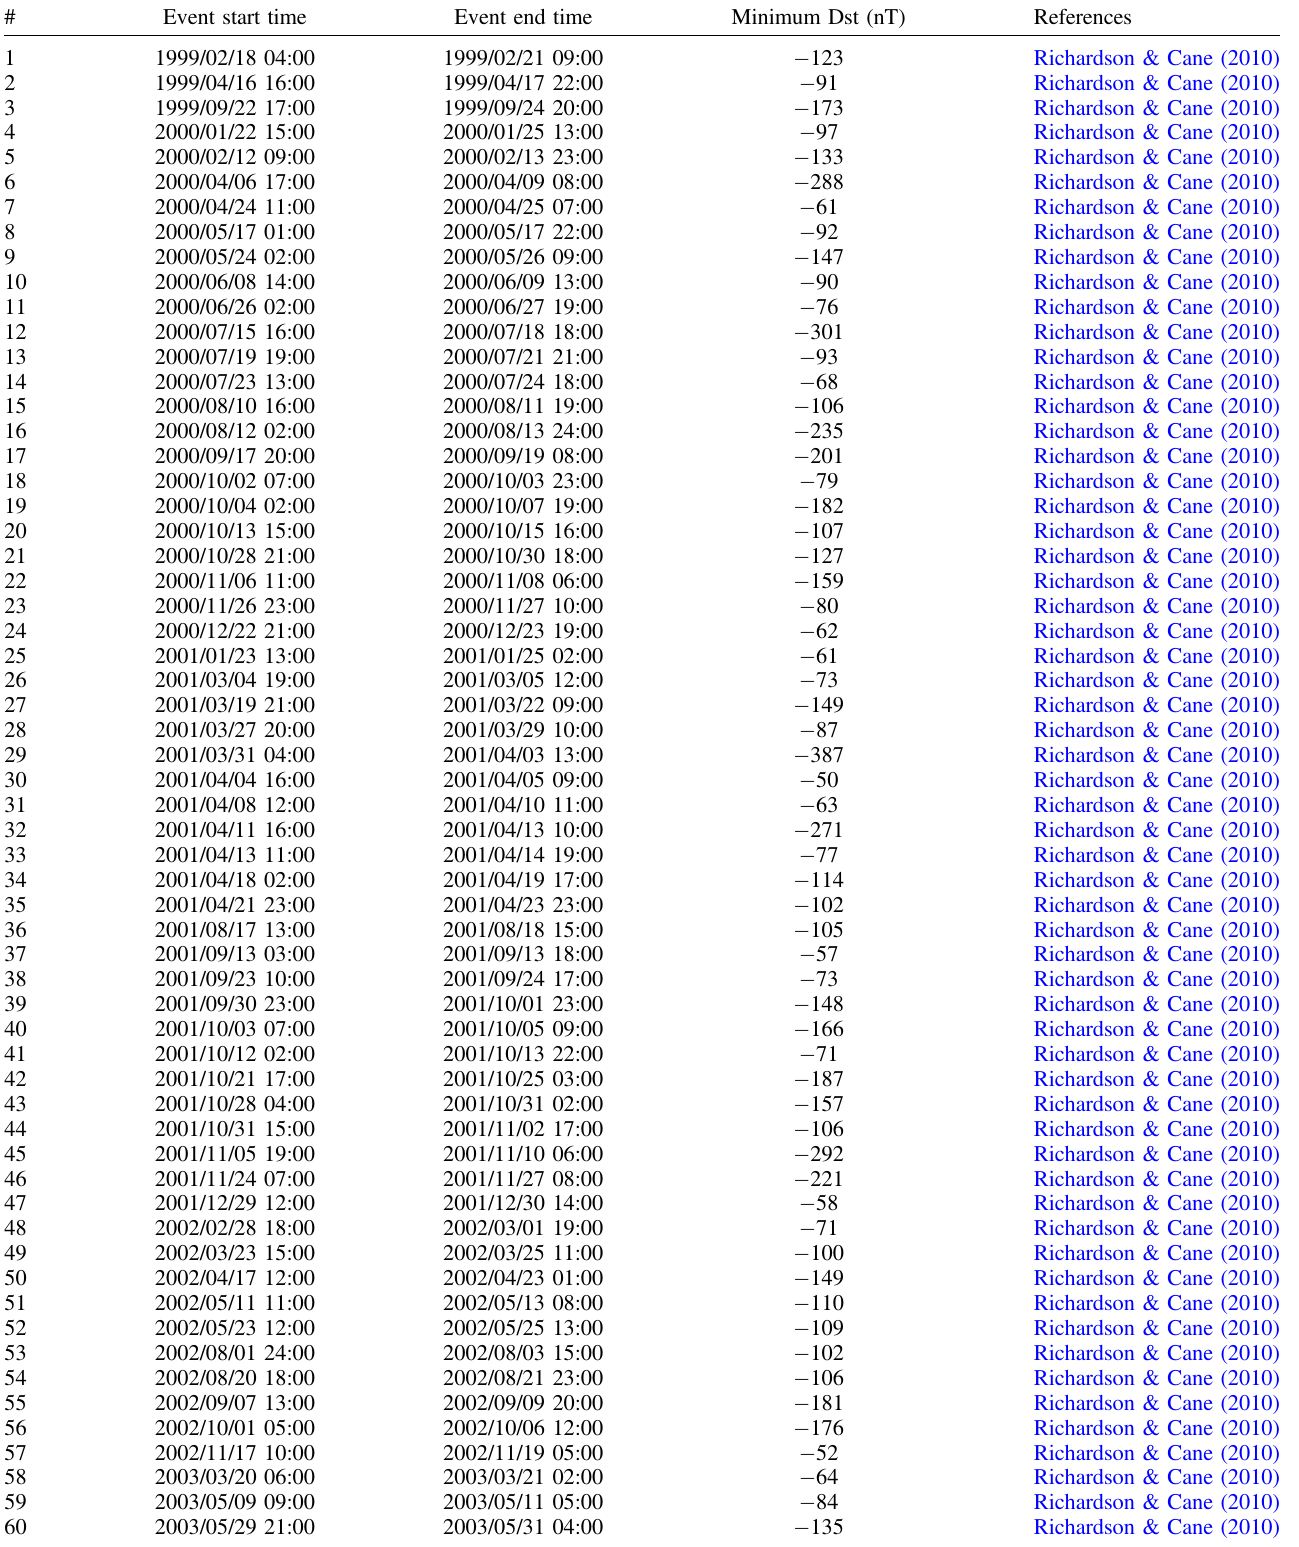
Table A.1. CME-driven geomagnetic storm